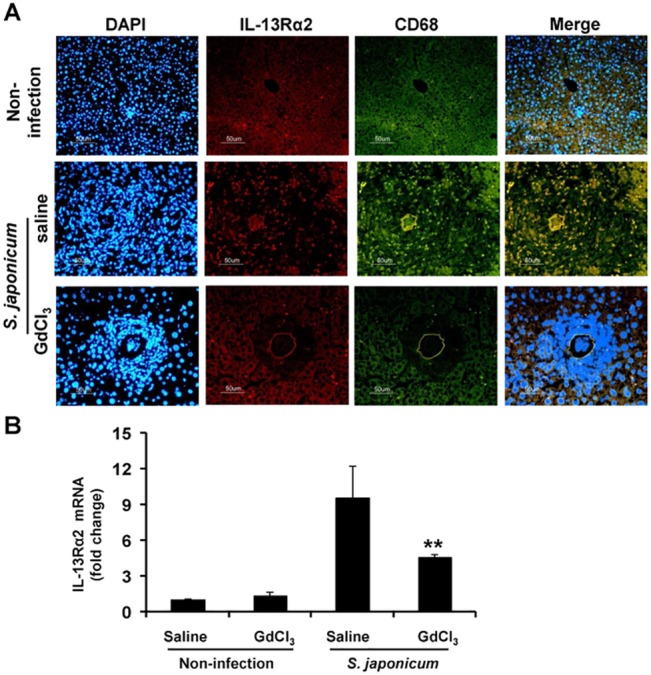
Effect of GdCl3 treatment on expression of IL-13Rα2 and CD68 in egg-induced hepatic granuloma.(A) Immunofluorescence double labeled staining was performed to detect IL-13Rα2 (red) and CD68 (macrophages marker, green) in liver sections, with DAPI (blue) conterstain for the nuclei. Merged images were shown in the right panels. Levels of IL-13Rα2 mRNA in livers tissues were measured by real-time PCR (B). **
P<0.01, vs infected mice treated with saline. Magnification ×400, bar scale 50 μm.